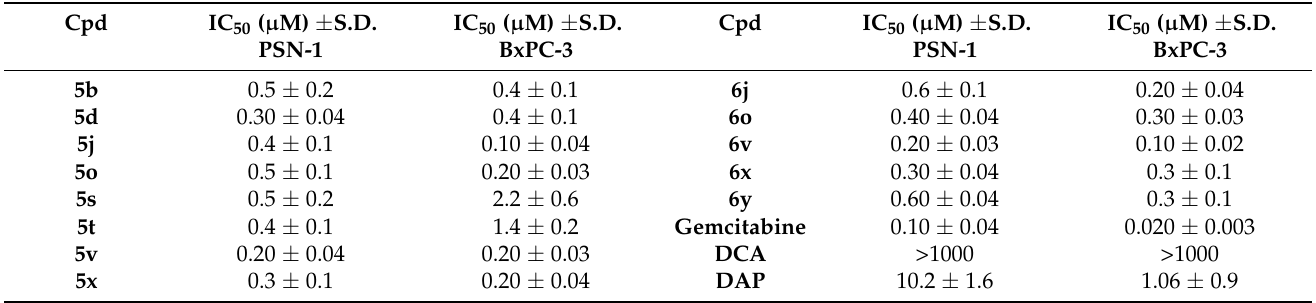
Table 2. Antiproliferative activity of the most representative compounds against PSN-1 and BxPC3 cancer cells evaluated in a 2D cytotoxicity